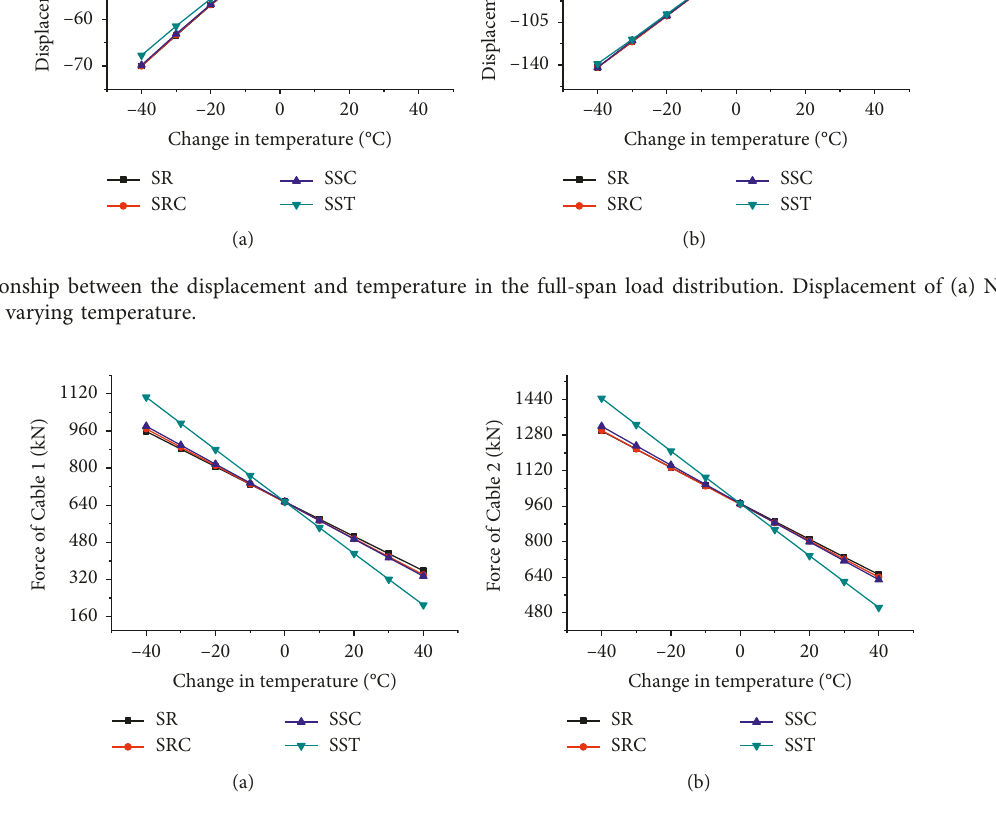
Figure 4: Relationship between the cable force and the temperature in the full-span load distribution. Change in the cable force of (a) Cable 1 and (b) Cable 2 with varying